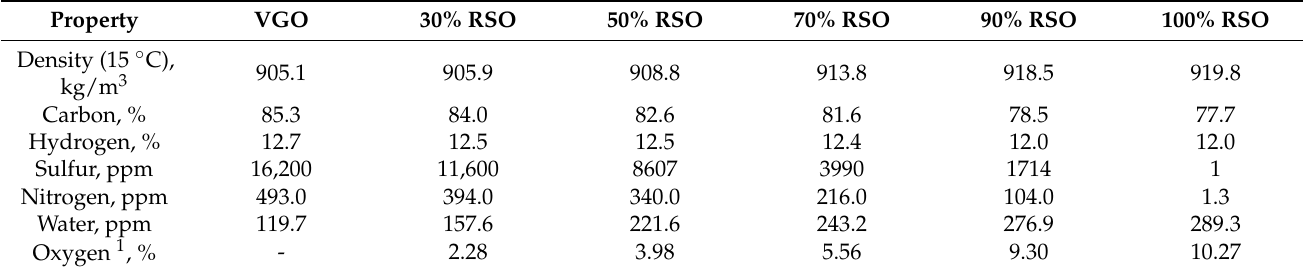
Table 1. Elemental composition of all utilized materials, including density and water